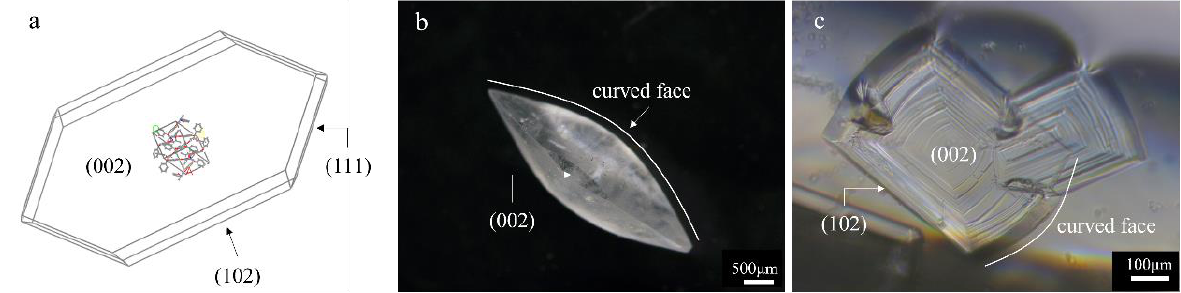
Figure 5. ( a ) The main crystal faces of pyriproxyfen predicted in vacuum; ( b ) pyriproxyfen crystal grown in heptane solution; ( c ) pyriproxyfen crystal grown in ethanol solution.